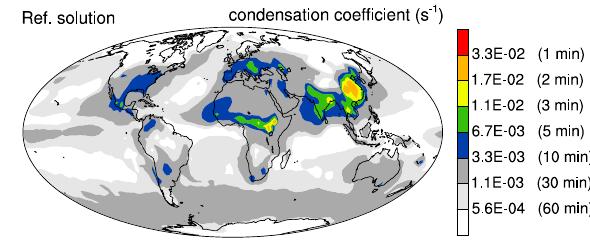
Fig. 4. Reference solution of the January-mean H 2 SO 4 gas conden- sation coefficient (unit: s − 1 ) in the lowest model layer. The numbers given in parentheses next to the color bar are the step sizes corre- sponding to the stability threshold 1t = 2 /C of the Euler forward time integration scheme (cf., e.g., Chapter 2 in Butcher, 2008).